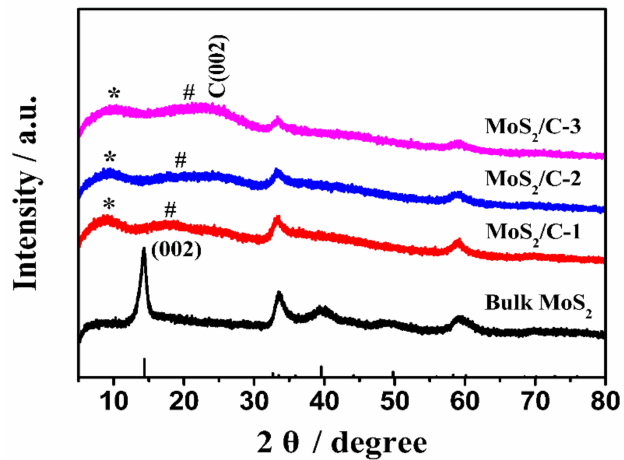
Figure 2. X-ray diffraction (XRD) patterns of the synthesized pristine MoS 2 and MoS 2 /C composites prepared with different amounts of glucose (a.u. is arbitrary